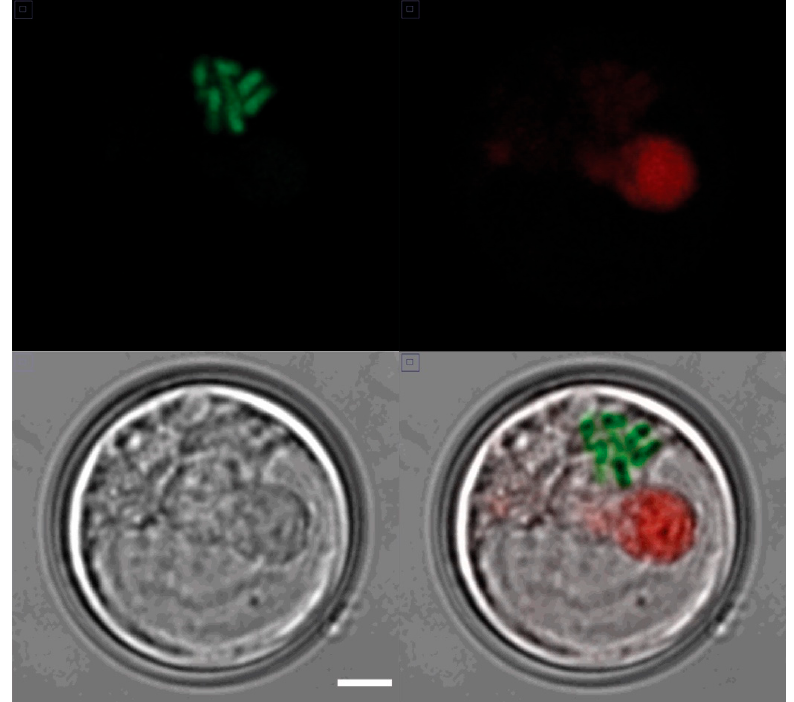
Figure 1. Condensed chromosomes in an interphase S. kawagutii cell. A confocal image of a single cell taken in (upper left) the green channel (PI staining of chromosomes), (upper right) the red channel (natural chlorophyll fluorescence), and (lower left) a DIC (Nomarski) image (scale bar 1 µm for all panels). A merged image is shown in the lower right.